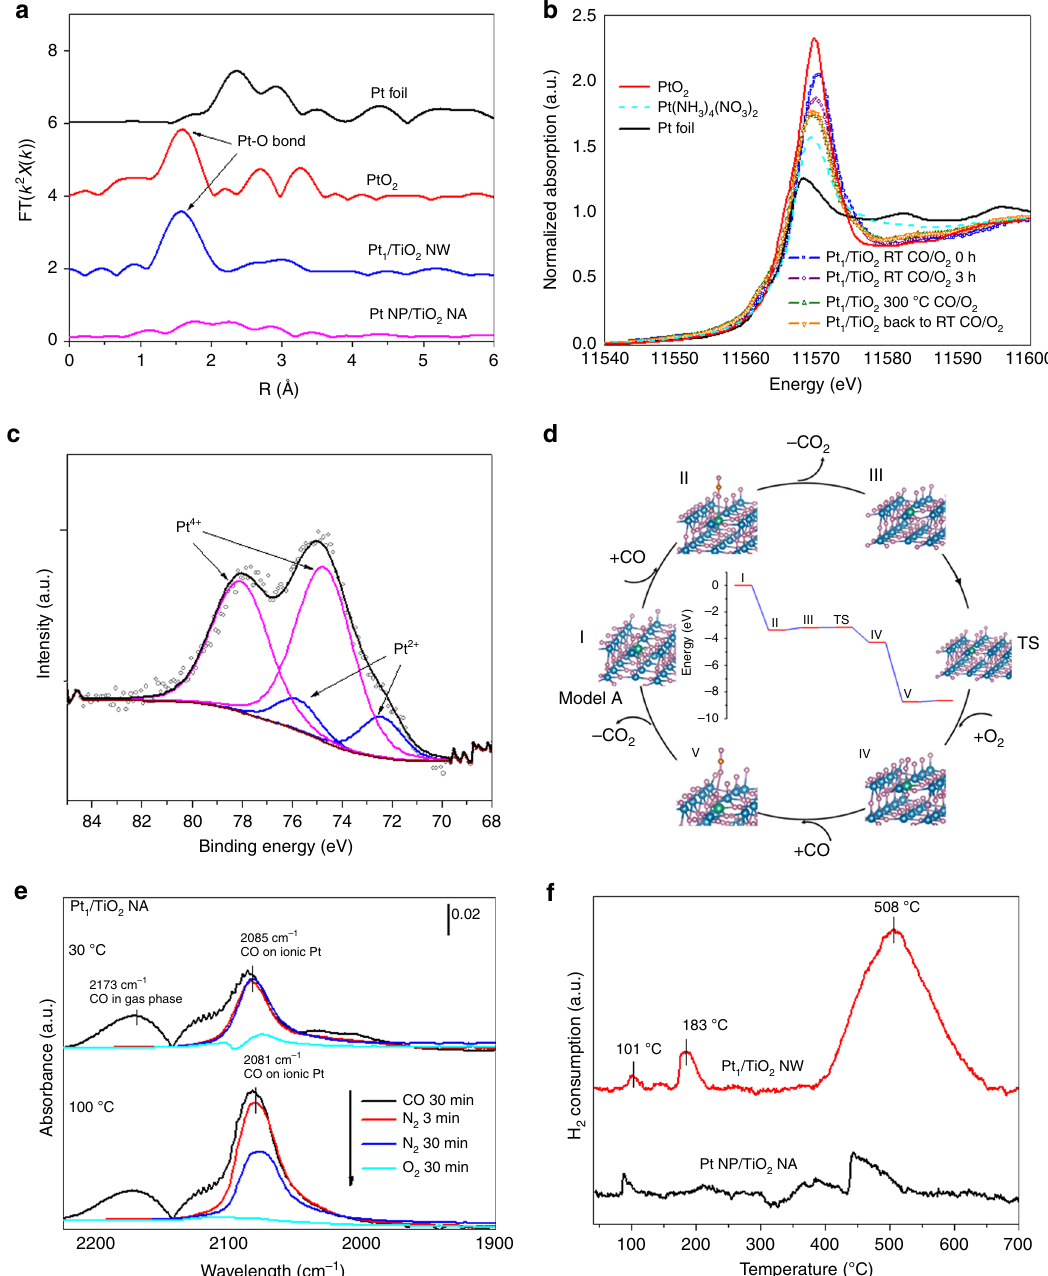
Fig. 2 Characterization of the Pt single-atom species on TiO 2 NW and NA surfaces. a k 2 -weighted Fourier-transformed EXAFS spectra of Pt 1 /TiO 2 NW. Pt NP/TiO 2 NA, Pt foil, and PtO 2 are employed as references. b Normalized XANES spectra at the Pt L 3 edge of Pt 1 /TiO 2 NW under in situ CO oxidation. c Core Pt 4 f XPS spectrum of the Pt 1 /TiO 2 NW. d The proposed Eley-Rideal mechanism for CO oxidation on Pt 1 /TiO 2 NA. The reaction cycle shows the structure of intermediates and transient state (TS) of the key elementary steps. The inset shows the calculated energy pro fi le. e In situ DRIFT spectra of CO adsorption and oxidation at 30 and 100 °C of Pt 1 /TiO 2 NA, and f , H 2 -TPR pro fi le of Pt 1 /TiO 2